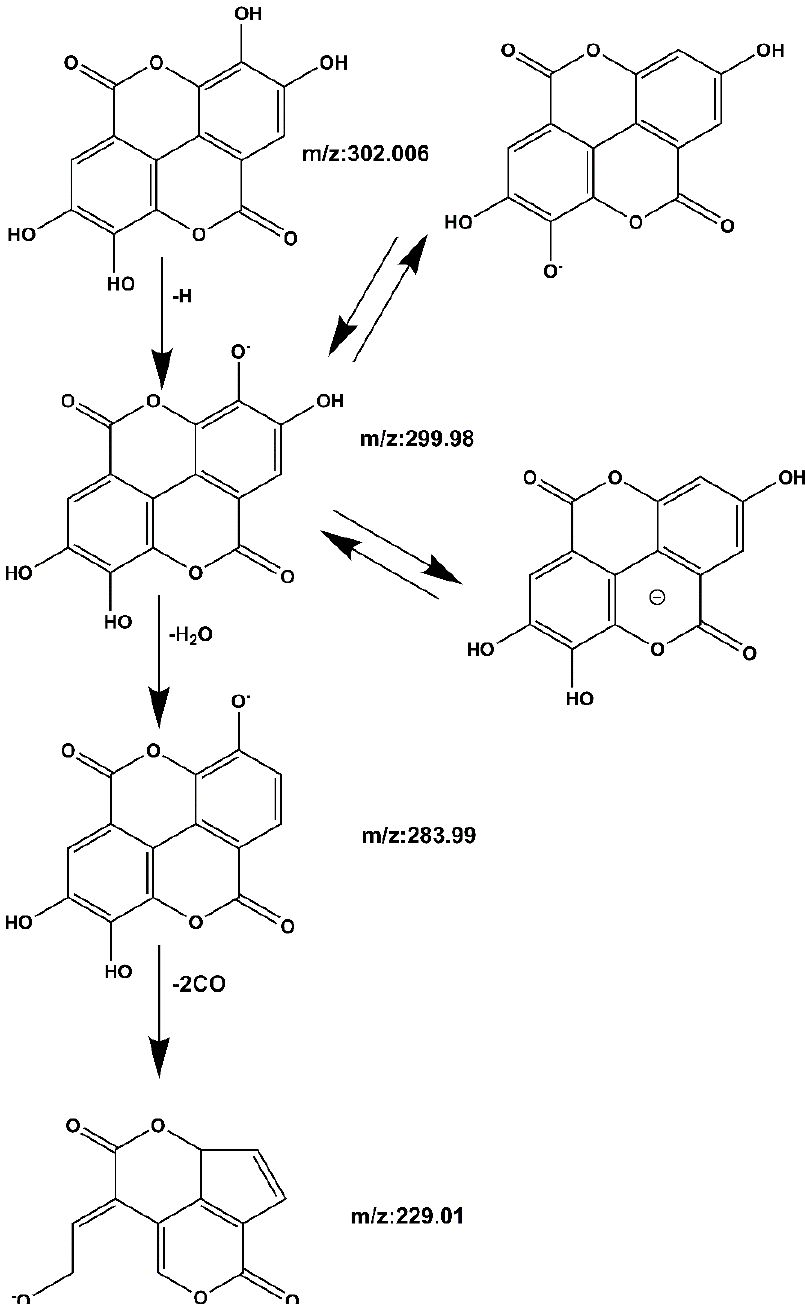
Figure 7. Ellagic acid mass spectrometric cleavage pathway